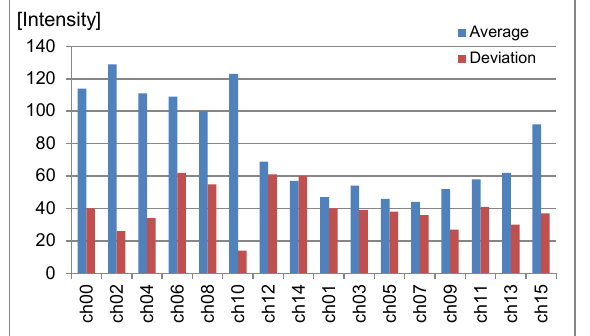
Figure 11. Analysed results of reflection intensity